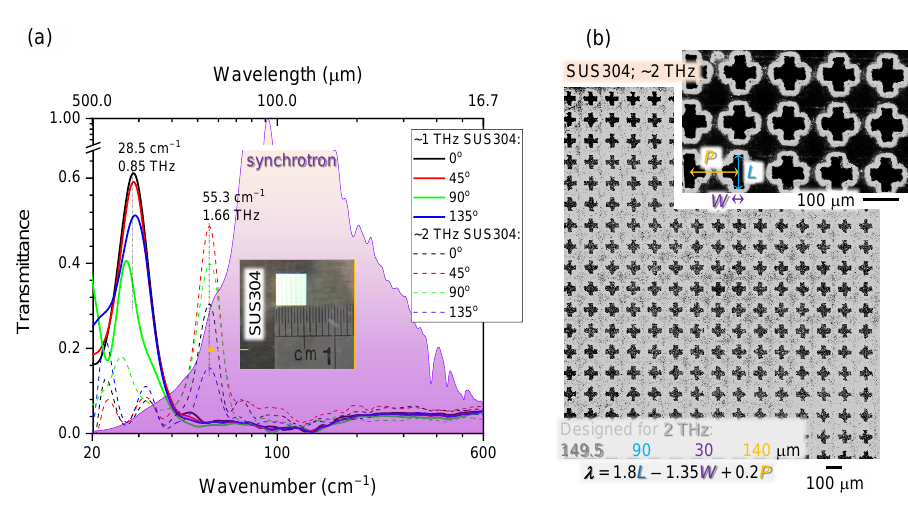
Figure 3. THz filters made out of 25- µ m-thick stainless steel SUS304. ( a ) Transmittance spectra at four polarisation angles for ∼ 1 and ∼ 2 THz filters. The background shows normalised AuSy spectra (with the Mylar 6 µ m beamsplitter used for detector). ( b ) SEM images of ∼ 2 THz